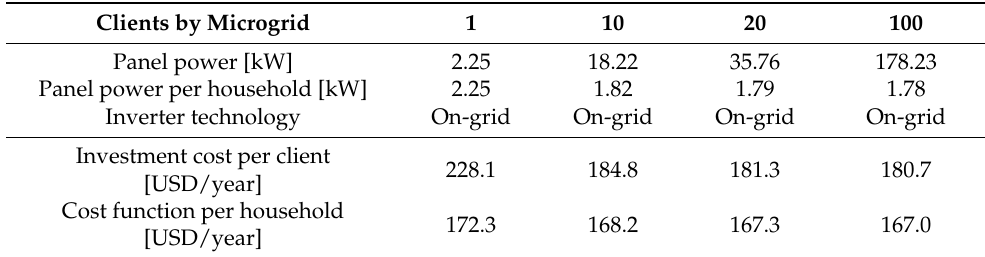
Table 5. Average results for microgrids without reliability